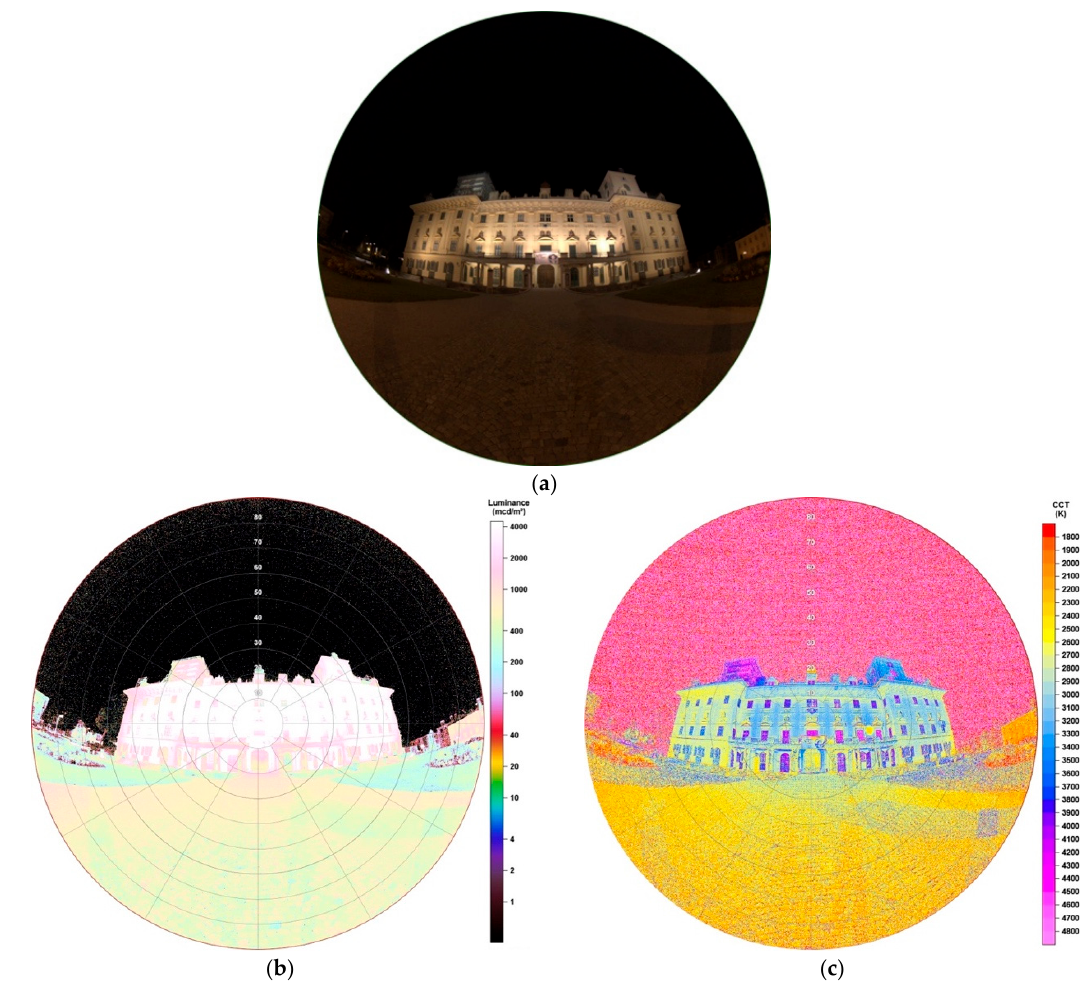
Figure 14. ( a ) Image of the illuminated Castle Esterházy during night-time, taken with fisheye lens for detailed analysis (date: 29.07.2019, 23:25 h; exposure time: 1/30 s); ( b ) Luminance matrix as displayed by SQC; ( c ) CCT matrix as displayed by SQC.